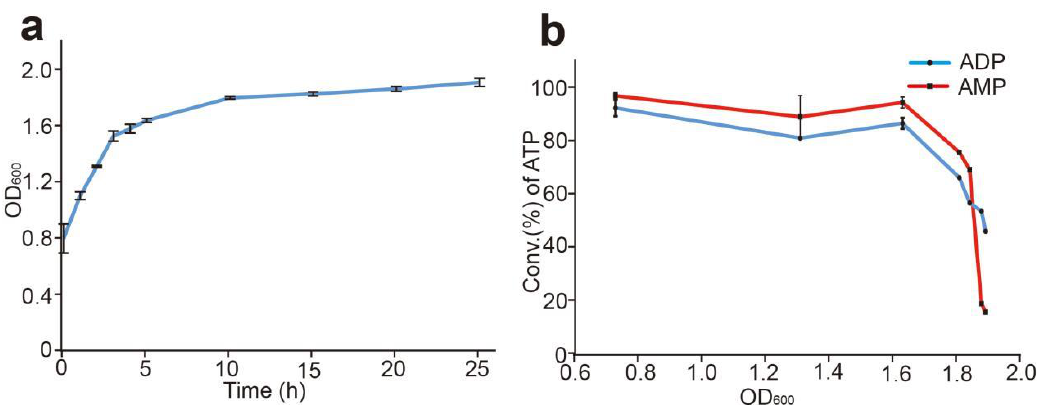
Figure 7. Effect of the cell state on the synthesis of ATP. ( a ): The growth curve of the sfGFP-PAP-Pb cells. ( b ): Analysis of ATP conversation using different states of the sfGFP-PAP-Pb cells. The reaction mixture contains 20 mM poly(P), 4 mM ADP or AMP, 30 mM Mg 2+ , and 50 mM Tris-HCl (pH 8.5), moderate cells were added. The total volume was bought up to 1 mL with double-distilled water. The reaction solution was incubated at 37 ◦ C for 20 min. A small amount of reaction solution was terminated in 80 ◦ C water bath for 10 min and diluted five-fold for HPLC analysis. Results are means ± SD of three parallel